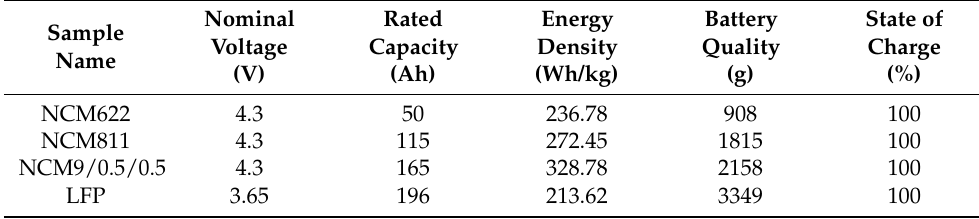
Table 1. Experimental battery